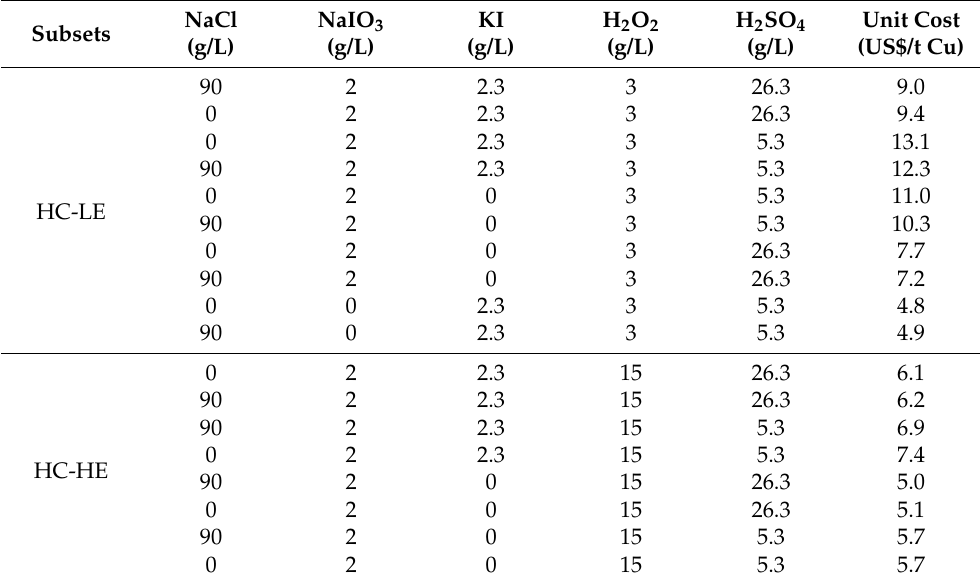
Table 7. Unit costs of leaching